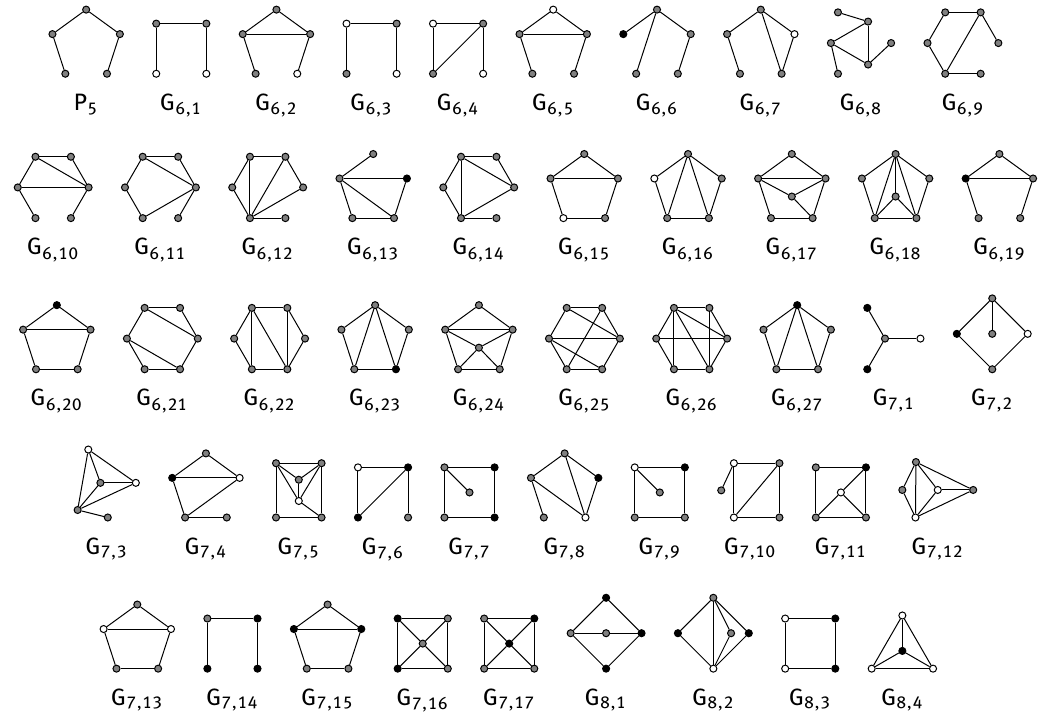
Figure 2: The family of graphs F 3 . A black vertex represents a clique of cardinality 2 , a white vertex represents a stable set of cardinality 2 and a gray vertex represent a single